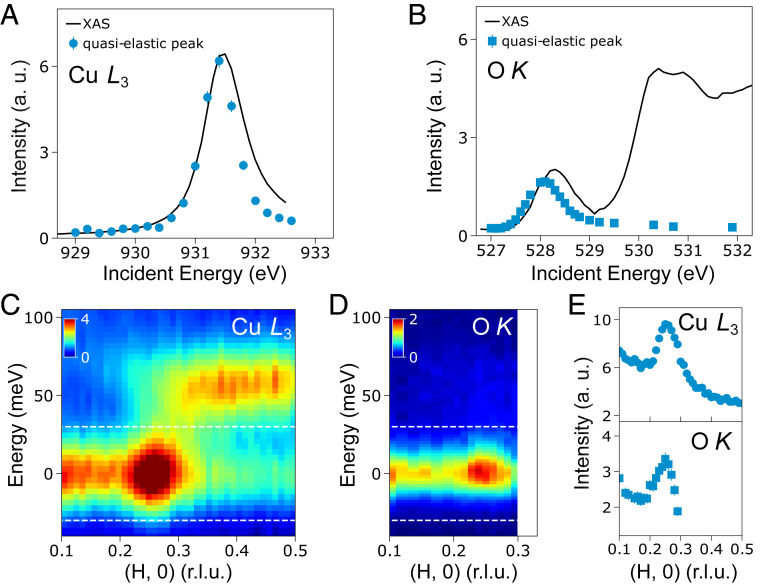
CDW in underdoped UD23. (A and B) Solid black lines: Cu L3- and O K- edges XAS of UD23 sample collected with σ incoming polarization in normal incidence geometry (see the experimental setup in SI Appendix, Fig. S2). Blue circles (squares): Energy-dependent scattering intensities of the quasielastic peaks at the Cu L3-edge (O K edge) at q// = 0.26 r.l.u. (0.25 r.l.u.). (C and D) RIXS intensity maps excited at, the Cu L3 resonance of 931.6 eV and the O K-edge hole-peak resonance of 528.4 eV as a function of energy and q// along the (H, 0) direction. (E) Integrated intensity of the quasielastic peak, at the Cu L3- and O K edges, within an energy window (±30 meV) marked by the two white dashed lines in C and D.